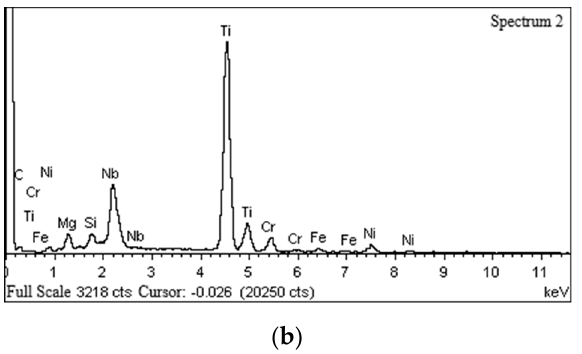
Figure 8. Ti − enriched belt on the rake face of SX9: ( a ) SEM micrograph; ( b ) EDS spectrum.